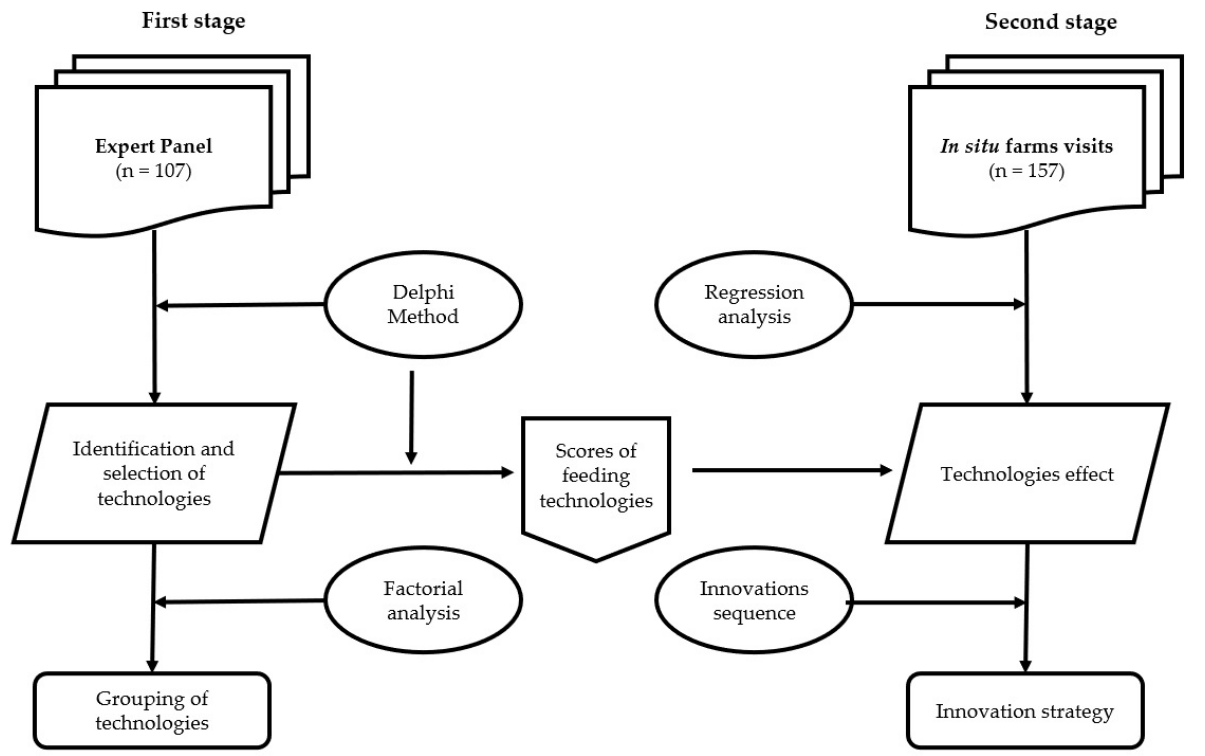
Figure 1. Research Figure 1 . Research steps.